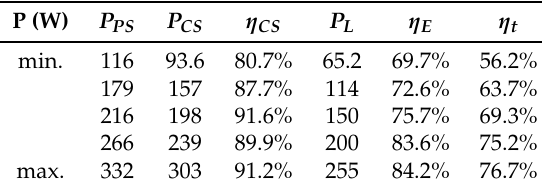
Table 1. Active power and efficiency